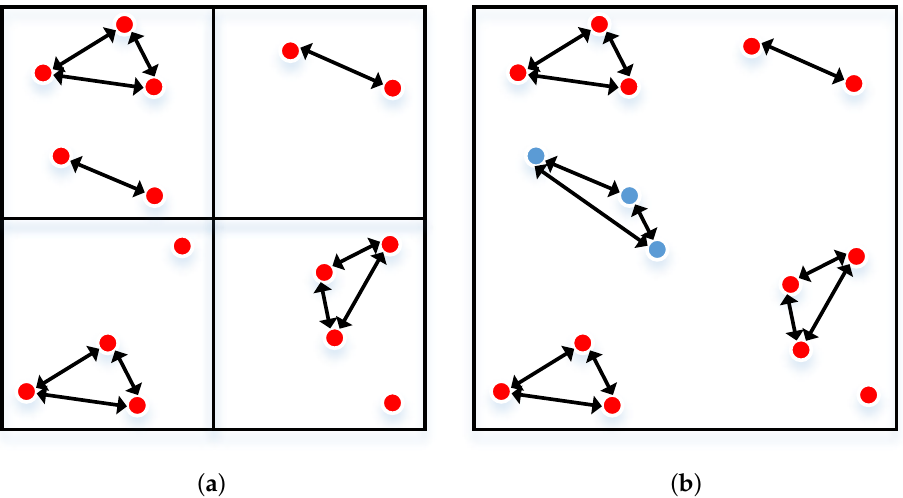
Figure 4. Example of multiple rounds of matching process. ( a ) Users (depicted as red points) match in a small range; ( b ) The remaining users (depicted as blue points) perform the second round of